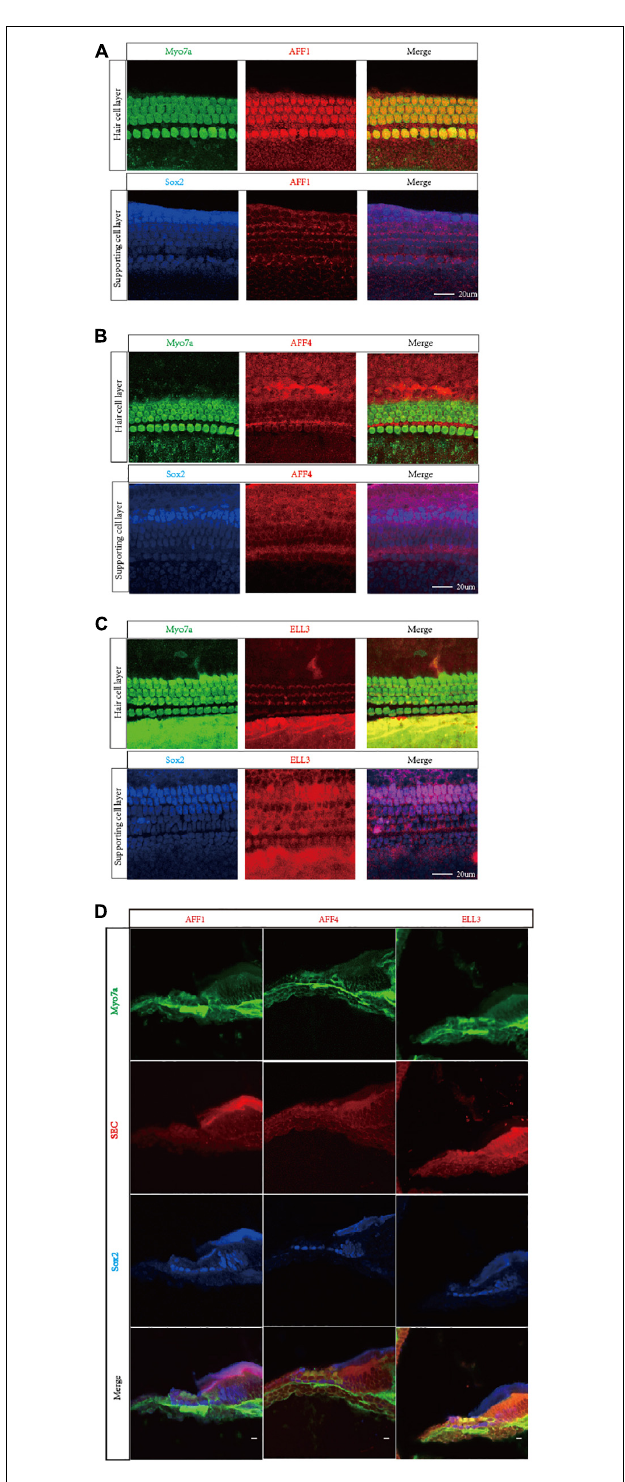
FIGURE 2 | Immunofluorescent staining of AFF1, AFF4, and ELL3 in the mouse cochlea. (A–C) The whole-mount basilar membrane of P3 was immunostained by antibodies against AFF1 (A) , AFF4 (B) , and ELL3 (C) . (D) Frozen sections of P40 were immunostained by antibodies against AFF1, AFF4, and ELL3. Myo7a and Sox2 were used to label hair cells (HCs) and supporting cells (SCs), respectively. Scale bar = 20 µ